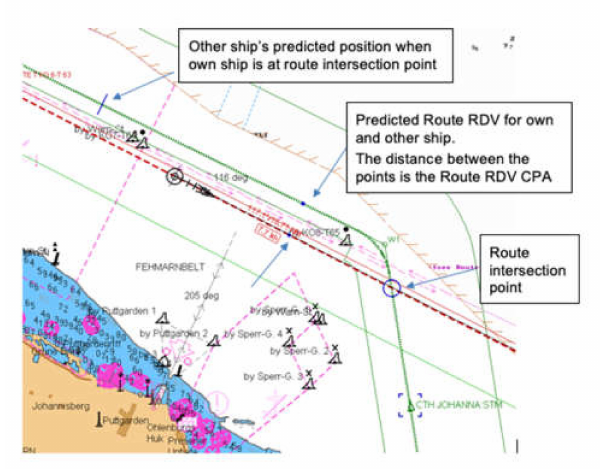
Figure 1. Screen capture of an electronic chart display and information system (ECDIS), with the S2SREX / RDV function in